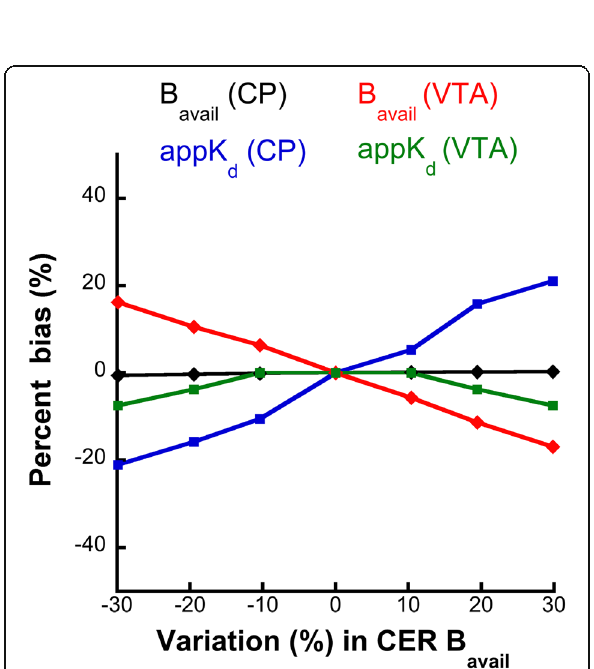
Fig. 4 The bias (%), in the B avail and appK d values in the CP and the VTA, induced by a simulated variation (%) in the specific binding in the Cer (reference region), expressed as a variation in the B avail of this VOI. The B avail estimations in the VTA and the appK d estimations in both CP and VTA may be considerably biased in case of a variation in the specific binding in the Cer. The B avail in the CP remains virtually unbiased and independent of any variation in the specific binding in the